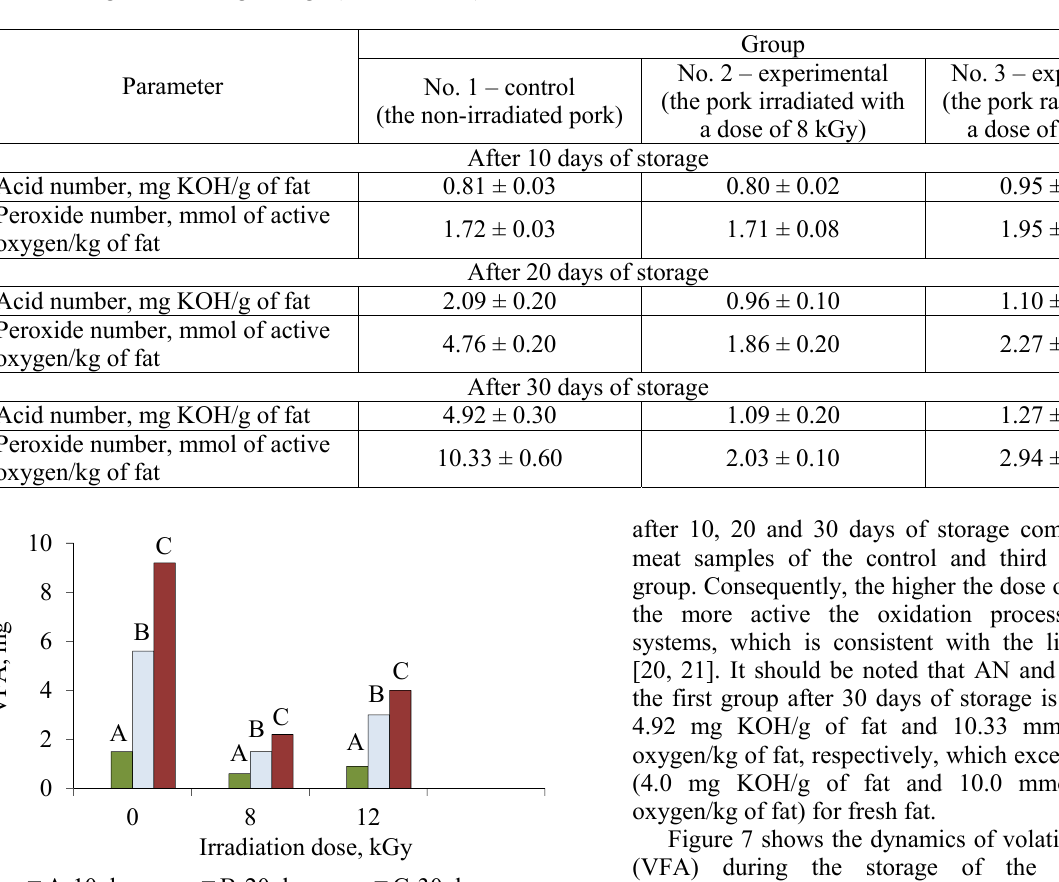
Table 2. Parameters of purity of fats in the control and experimental samples of the refrigerated pork neck on the bone packed using MAP during storage (M ± m; n = 5)